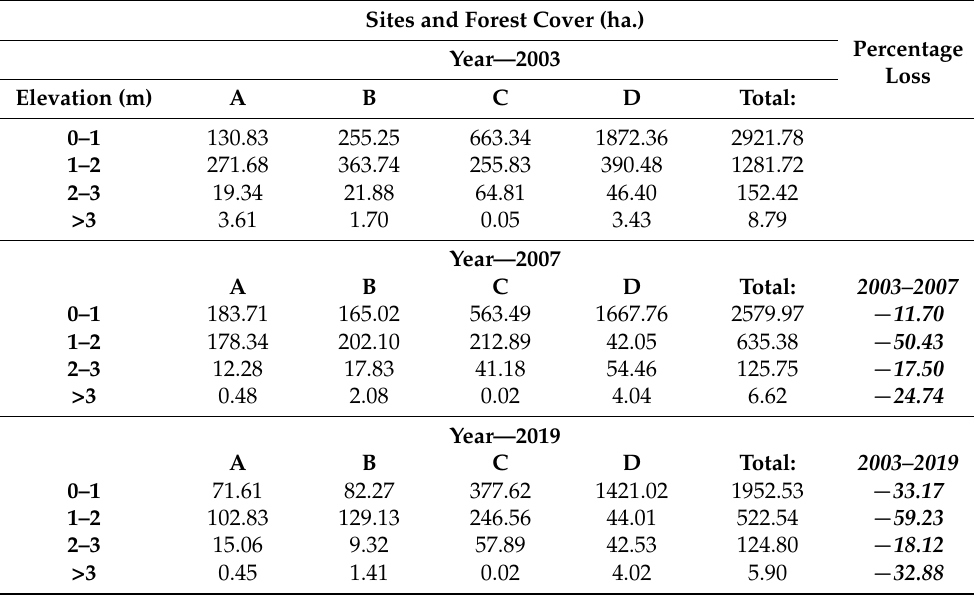
Table 2. Differences in the amount of forest area within each elevation band and the associated percentage loss of forest cover between years. Sections A, B, C, and D represent areas delineated for this study within the two parishes (for details see Figure 1). Sites and Forest Cover (ha.) Percentage